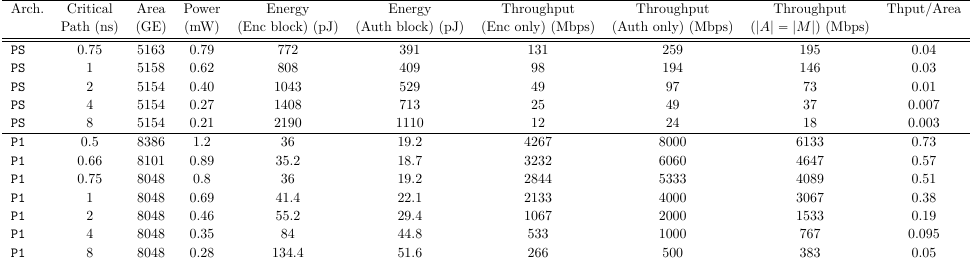
Table 12: The design space of Romulus - N 1 using the TSMC-65 ASIC technology: byte serial